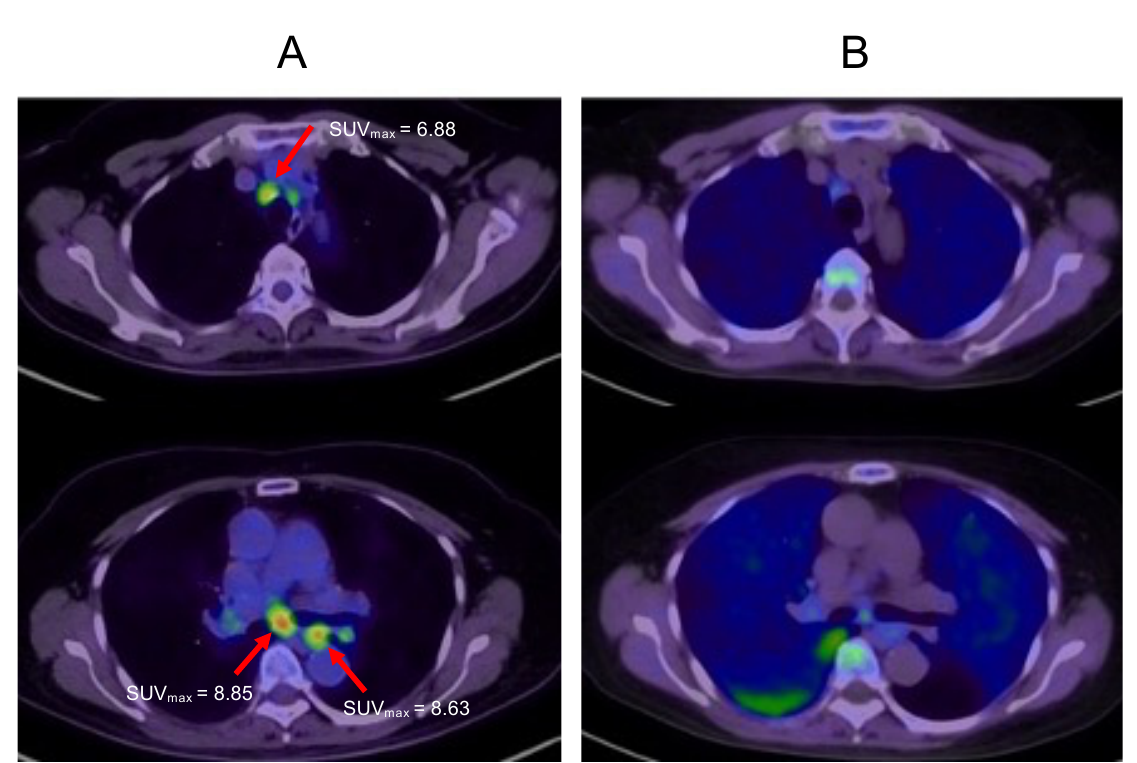
Figure 2. Multiple mediastinal lymph node nodules. ( A ): FDG ‐ PET imaging. ( B ): MET ‐ PET imaging. Arrows indicate mediastinal lymph nodes.